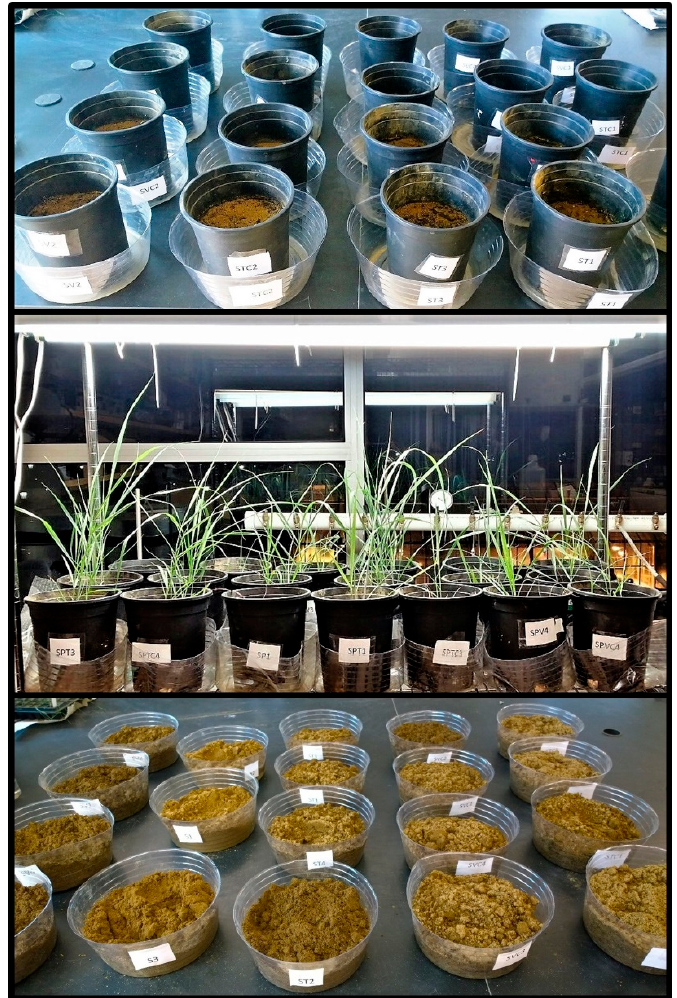
Figure 1. ( Top ): Pots containing contaminated soils amended with the different organic treatments without switchgrass placed over plastic containers used for leachate collection, ( Middle ): Vegetated pots containing switchgrass growing in laboratory under 24-h light conditions, ( Bottom ): Soil that was removed from the pots at the end of the experiment for analysis.